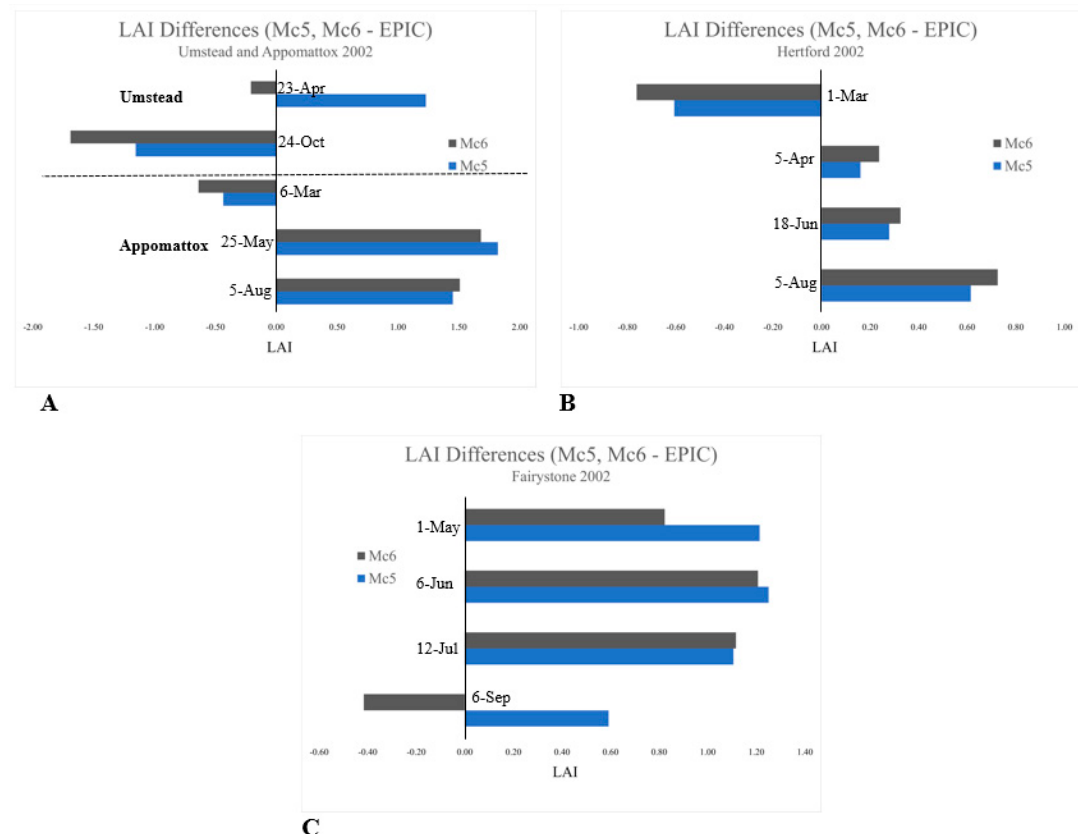
Figure 9. Weighted mean LAI differences of MODIS (Mc5 and Mc6) to EPIC modeled LAI across Appomattox ( A ), Umstead ( A ), Hertford ( B ), and Fairystone ( C ) across 13 dates.